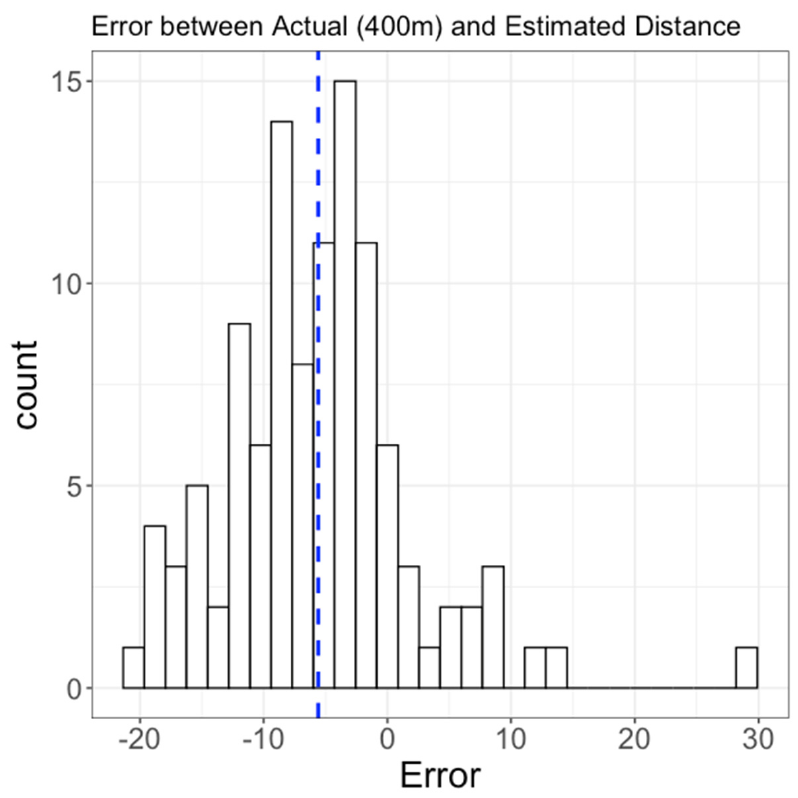
Figure 3. Histogram of error between 400 m and a total distance walked estimated by the proposed algorithm in 108 older adults (Study I). Vertical dashed line represents a mean of the histogram.